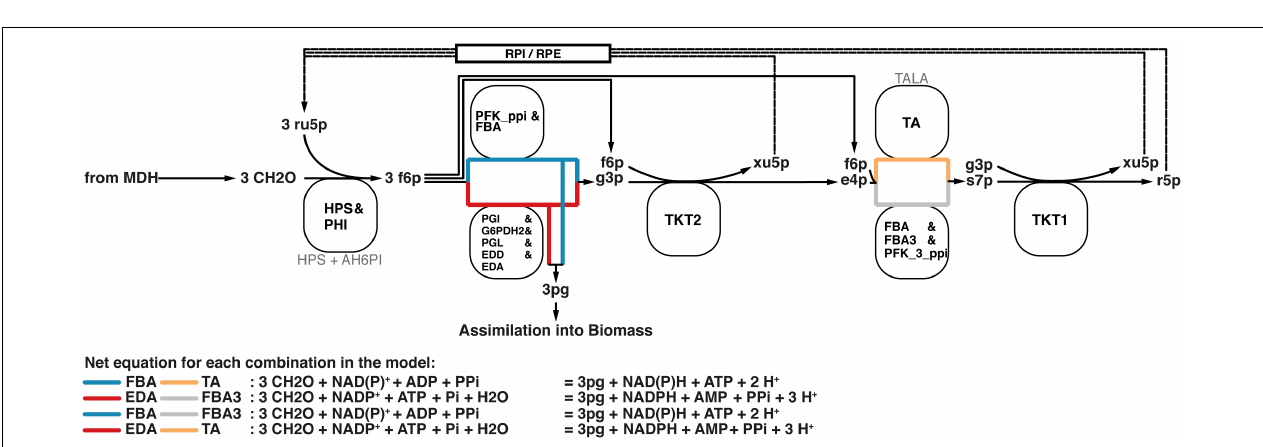
FIGURE 3 | Three different formaldehyde oxidation pathways are represented in the model. Black text denotes the common name, while faint gray text denotes the reaction ID in the metabolic model.